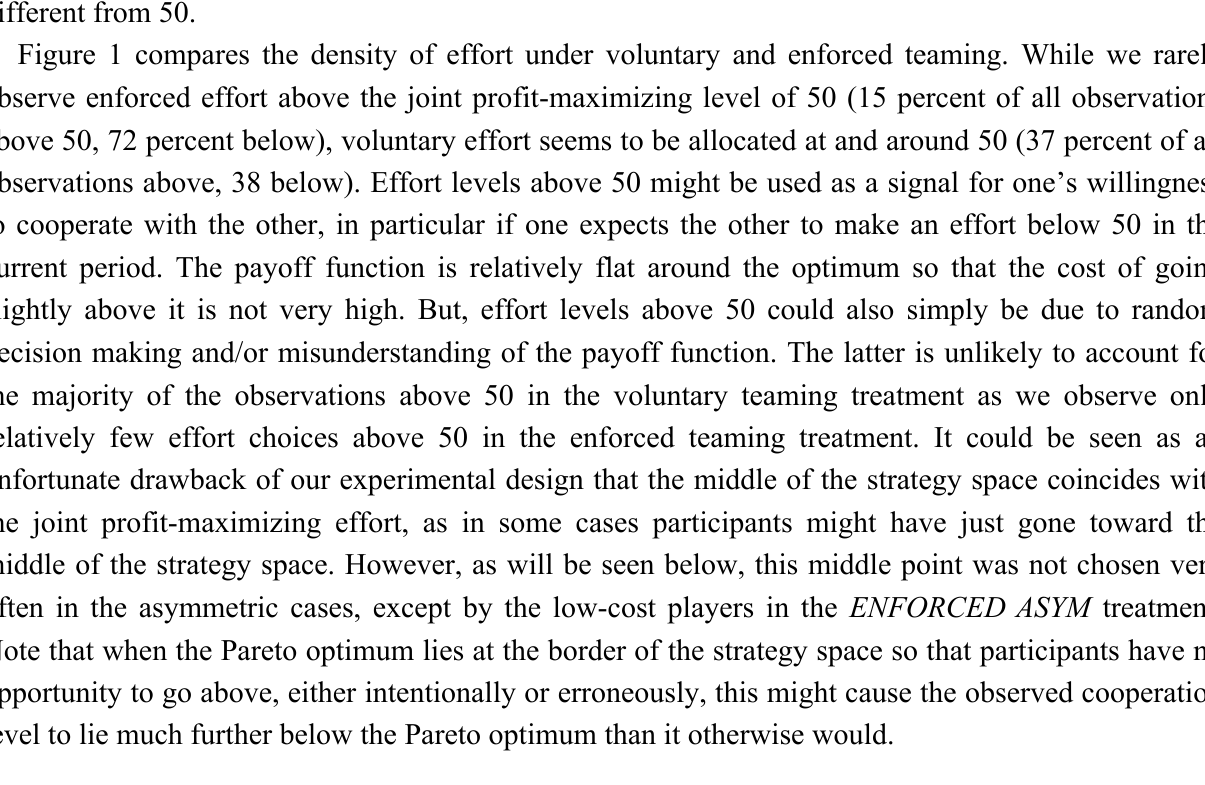
Figure 1. Density of team effort in the VOLUNTARY and ENFORCED SYM